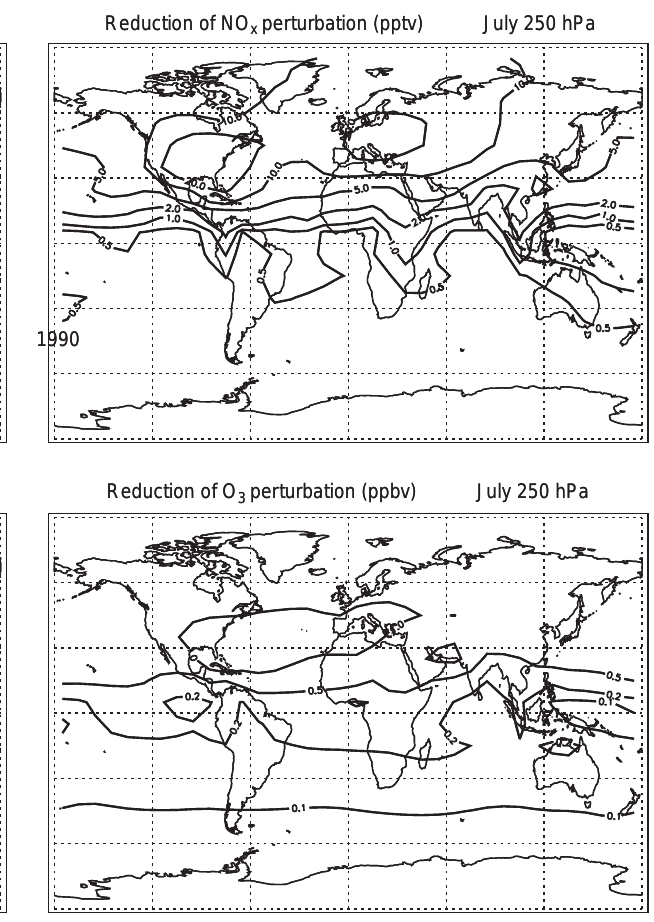
Fig. 6. Di(cid:128)erence between the perturbation of NO (ppbv) at 250 hPa due to modified and unmodified aircraft emissions for January and July for the reference year 1990. Positive numbers